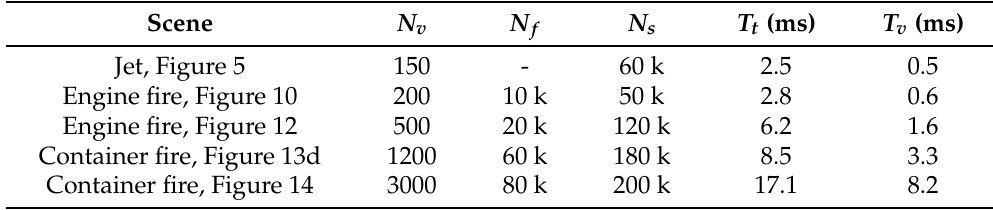
Table 1. Performance statistics of smoke and fire simulations.